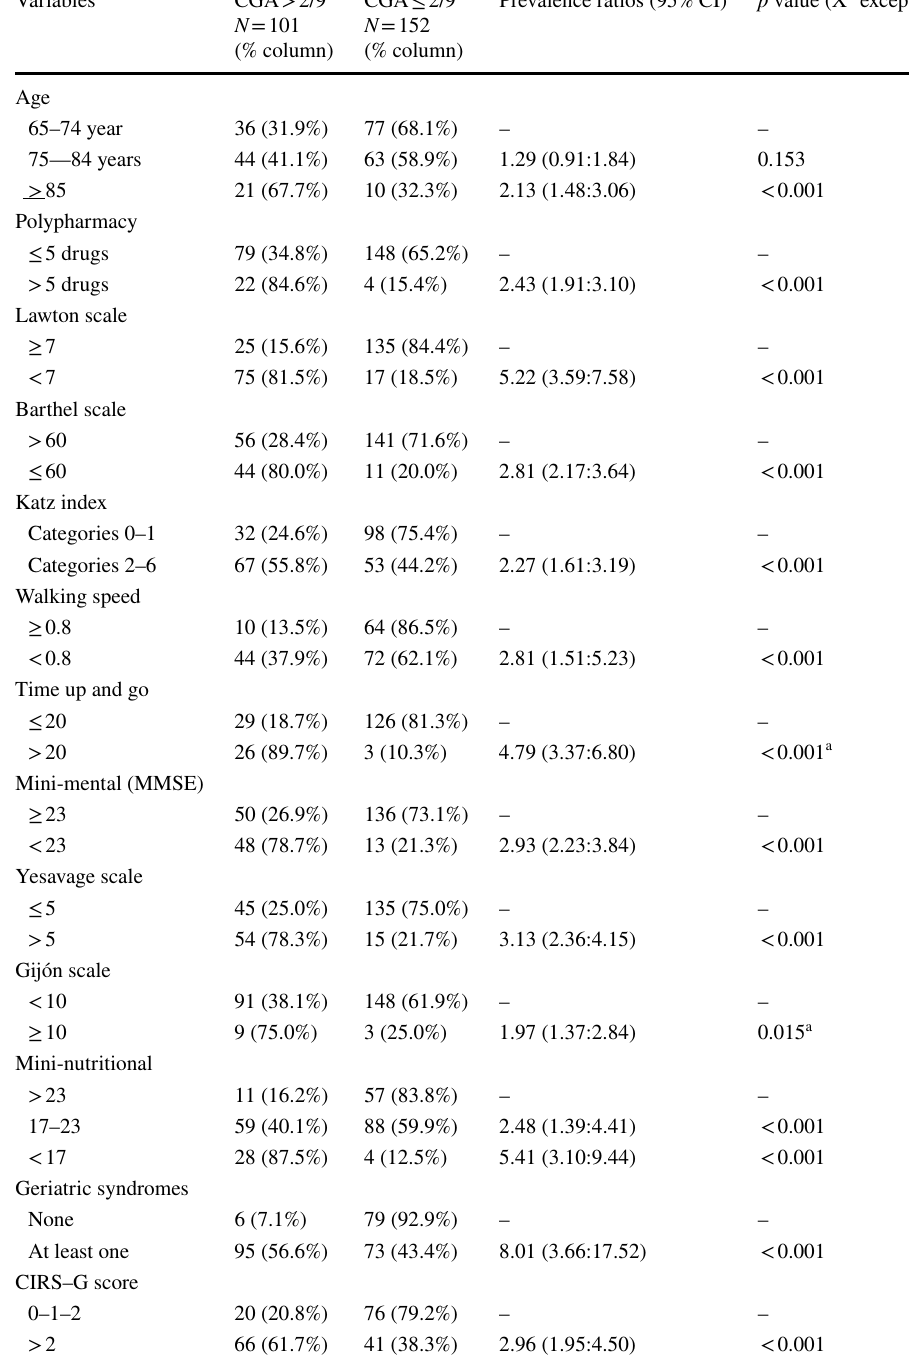
frailty as a dependent variable (as defined per the study: with 2 or more comprehensive geriatric assessment domains